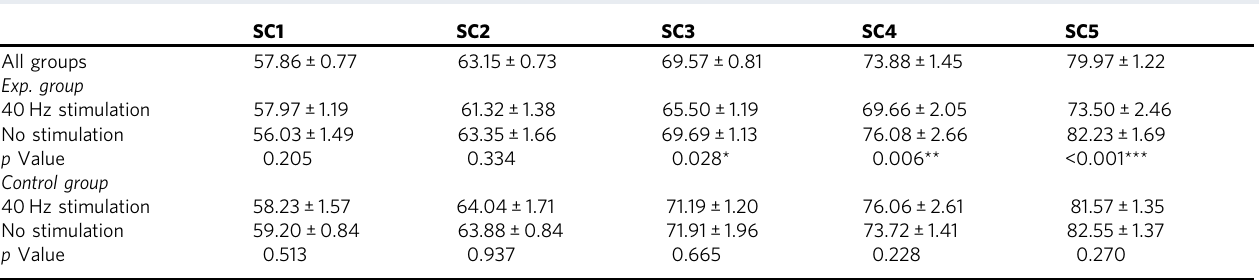
Table 2 Effects of optogenetic stimulation on grayscale visual